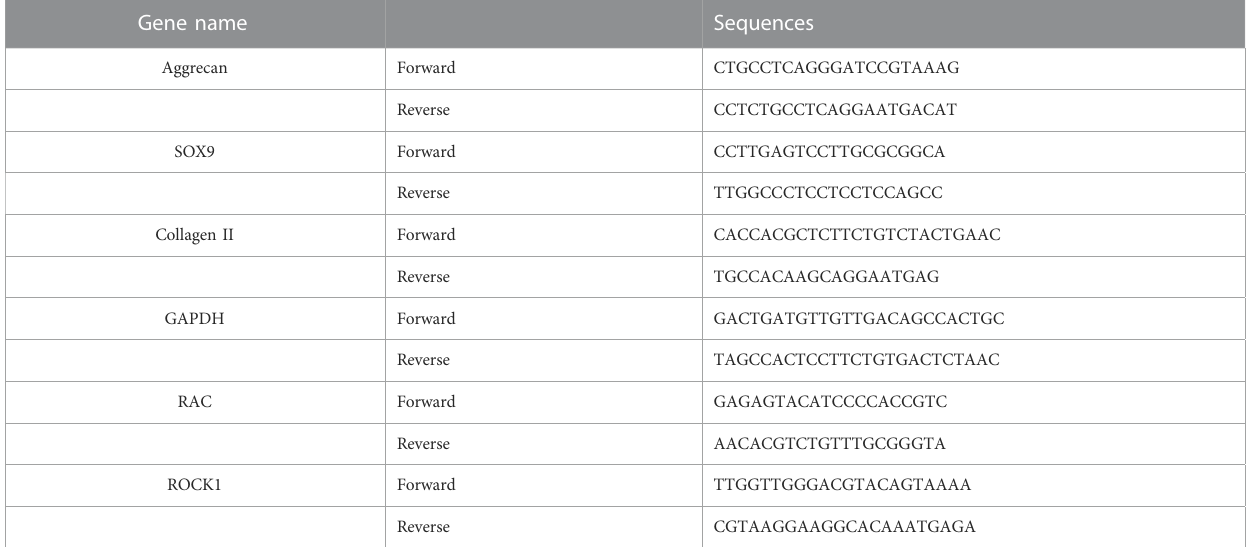
TABLE 2 Primer sequence used in vitro